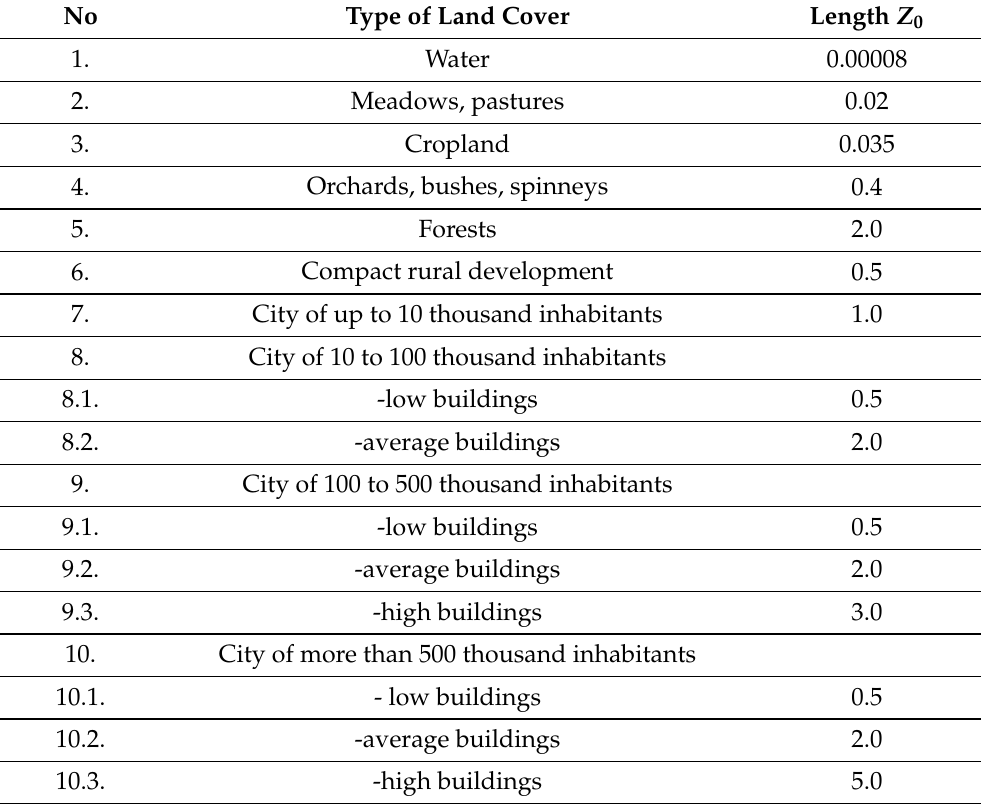
Table 2. Values of the aerodynamic roughness length Z 0